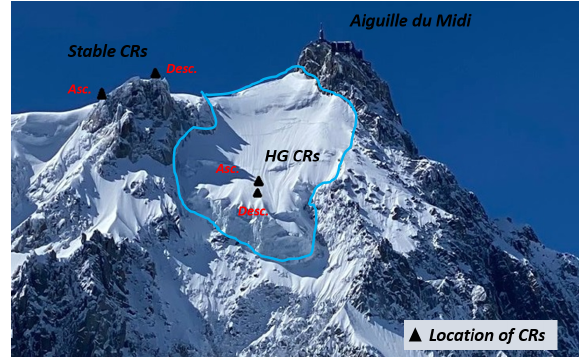
Figure 1. Study site and the locations of the CRs.